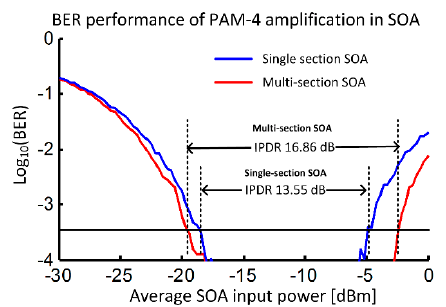
Figure 6. BER performance of pre-amplified 28 Gbaud PAM4 signals using a single section SOA (blue) and multi-section SOA (red). The multi-section SOA outperforms the single SOA with improved IPDR from 12.91 dB to 16.04 dB.